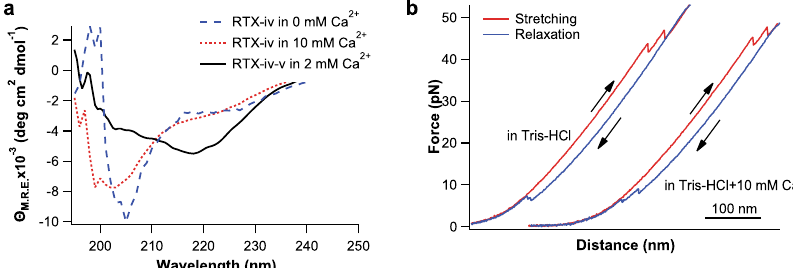
Fig. 2 RTX-iv alone is intrinsically disordered. a Far UV CD spectrum of RTX-iv in the absence of Ca 2 + and the presence of 10 mM Ca 2 + . b Representative F – D curves of NuG2-RTX-iv-NuG2 in Tris-HCl (left) and Tris-HCl + 10 mM Ca 2 + (right) at a pulling speed of 50 nm/s. Only the unfolding and refolding events of NuG2 domains were observed, suggesting that RTX-iv alone behaved as a disordered